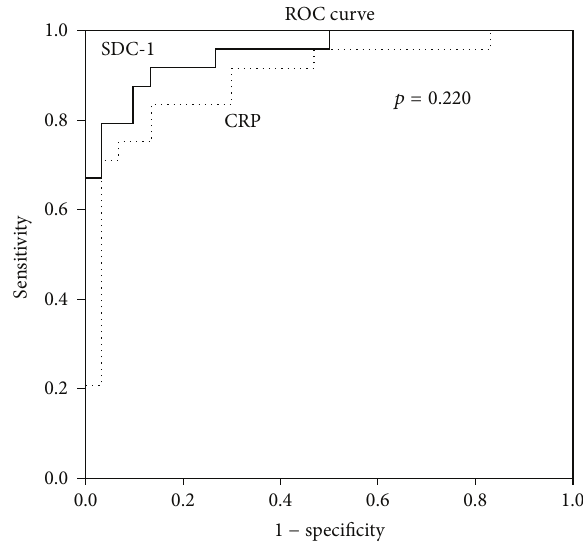
Figure 2: Efficiency of SDC-1 and CRP levels for the assessment of disease